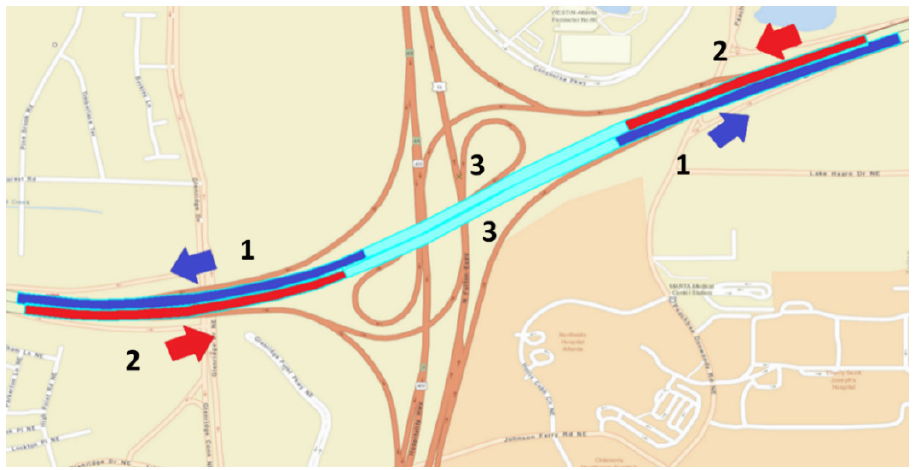
Figure 1. Definition of three segment types at an interchange: ( 1 ) merging in blue, ( 2 ) diverging in red, and ( 3 ) within in cyan.